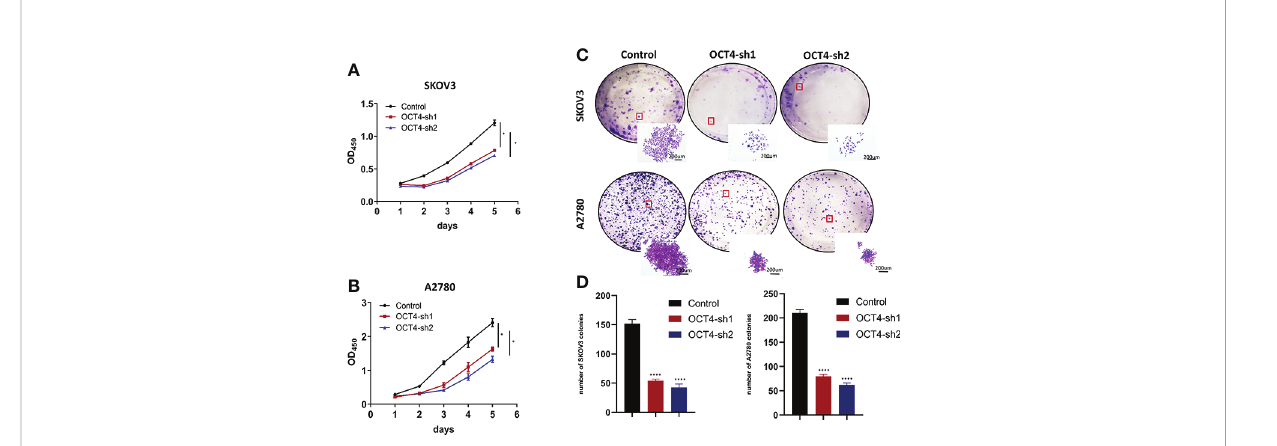
FIGURE 3 Knockdown of OCT4 inhibited the proliferation of OC cells (A, B) In SKOV3 and A2780 cell lines, cell viability was measured by CCK-8 assay. (C, D) Colony formation assays and statistical analysis in SKOV3 and A2780 cell lines. (Data were expressed as the mean ± SD. Signi fi cance was calculated using Student's t-test. *P<0.05,